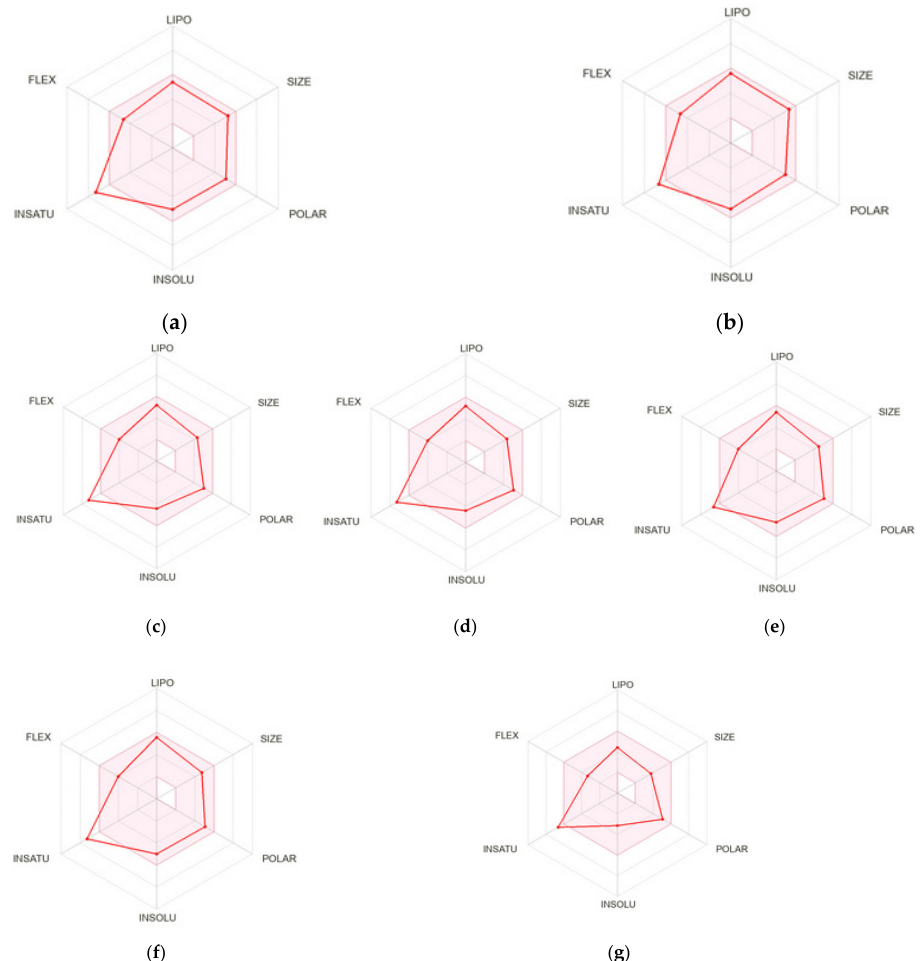
Figure 4. Bioavailability radar: ( a ) compound 6e ; ( b ) compound 8e ; ( c ) compound 6g ; ( d ) compound 9a ; ( e ) compound 9b ; ( f ) compound 9d ; ( g ) compound 9g .